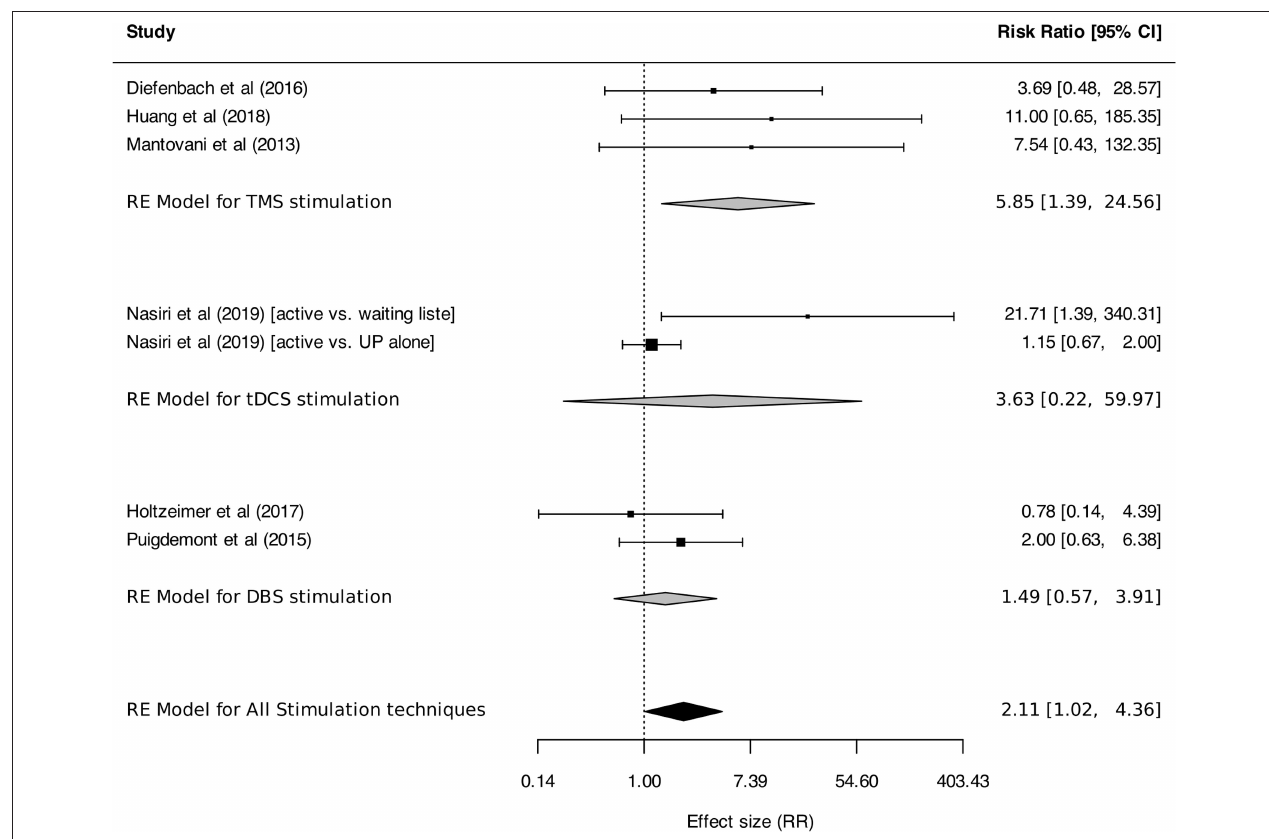
FIGURE 6 | Remission rates for anxiety, stressor-related disorders and MDD, subgroups by stimulation technique. Statistics: TMS: heterogeneity Sigma1 2 = 0.00, Sigma2 2 = 0.00, Q(df = 2) = 0.42, p = 0.81; I 2 = 0%; test for overall effect: Z = 2.41 ( p = 0.02); tDCS: heterogeneity Sigma1 2 = 0.00, Sigma2 2 = 3.28, Q(df = 1) = 4.20, p -val = 0.04; I 2 = 76%; test for overall effect: Z = 2.41 ( p = 0.02); DBS: heterogeneity Chi 2 = 0.79, df = 1 ( p = 0.37); I 2 = 0%; test for overall effect: Z = 0.90 ( p = 0.37); Total: heterogeneity Sigma1 2 = 0.00, Sigma2 2 = 0.29, Q(df = 6) = 9.15, p = 0.17; I 2 = 33%; test for overall effect: Z = 2.01 ( p = 0.04); test for subgroup differences: F(df1 = 2, df2 = 4) = 0.97, p =